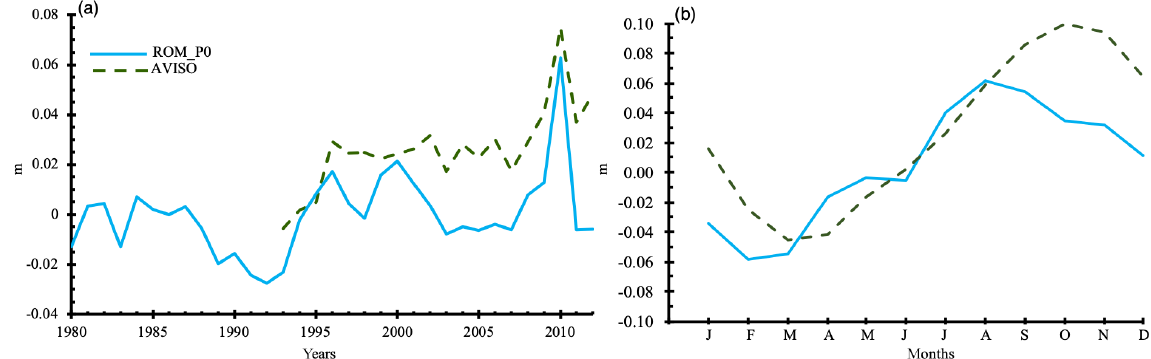
Figure 12. Time series of mean (1980–2012) sea level anomalies averaged over the Mediterranean basin ( a , in m). For ROM_P0 (blue), the dynamic SSH is added to the thermosteric term. Model data are compared to observations (dashed green, AVISO). ROM_P0 seasonal cycle data are compared to AVISO data (b) .